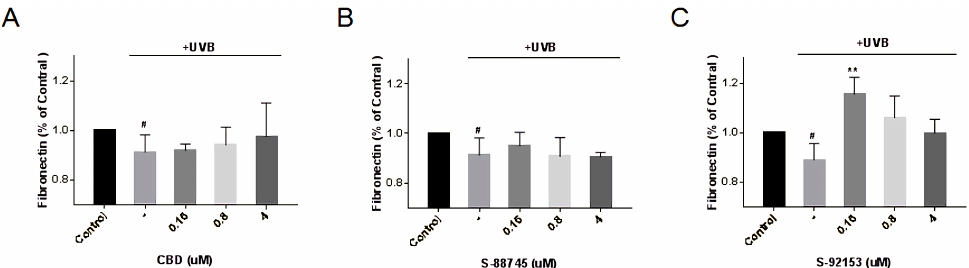
Figure 14. Production of ( A ) CBD, ( B ) S-88745 and ( C ) S-92153 on UV-stimulated fibronectin in HFF-1. The control group was not stimulated by UV. The UV-treated group (-) was stimulated by UV to cause ECM degradation. The experiments were repeated three times. Each bar illustrates the average ± standard deviation (SD) counted from three experiments. p < 0.05 was considered statistically significant. ** p < 0.01 compared to the UV − treated group; # p < 0.05 compared to the control group.